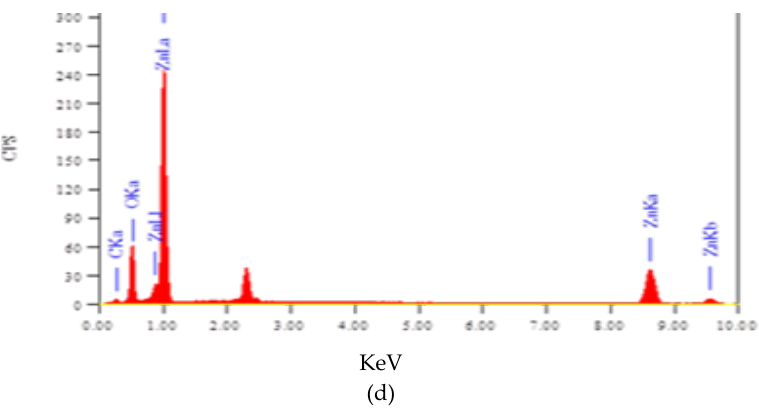
Figure 9. EDS spectra of ( a ) PNC, ( b ) nZnO, and the electrode paste ( c ) with and ( d ) without nZnO.